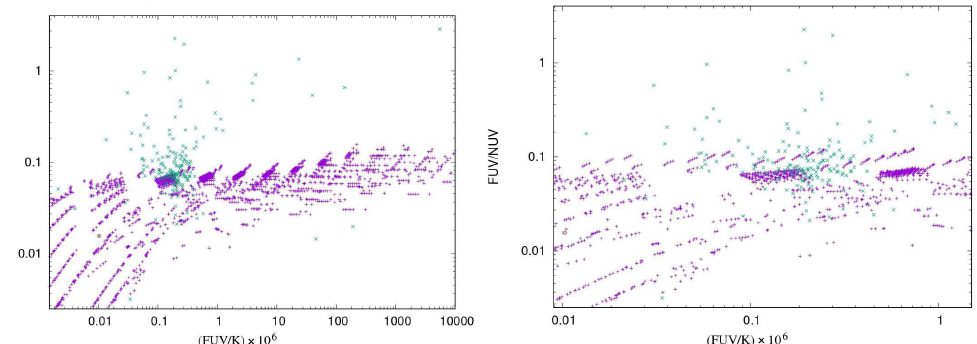
Figure 6. ( Left ) The observed (green symbols) and model (purple symbols) FUV/NUV flux ratio, R FUV / NUV , versus the FUV/K-band (2MASS) flux ratio, for AGB stars that were detected in both UV bands with SNR of ≥ 5. ( Right ) An expanded view of the central region in the plot on the ( Left ).